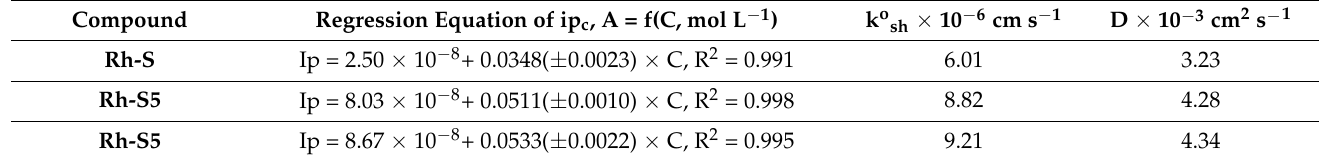
Table 4. Equation of regression of Ip c vs. concentration (C, mol L -1 ); heterogen rate constant and diffusion coefficient of Rh-S, Rh-S5, and Rh-S6 peptide derivatives at HMDE electrode (with elec- trode area, A = 0.030 cm 2 ).